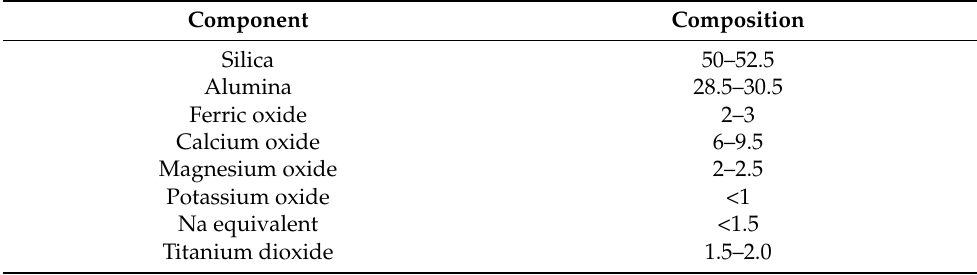
Table 2. Chemical composition of fly ash and % of mass.